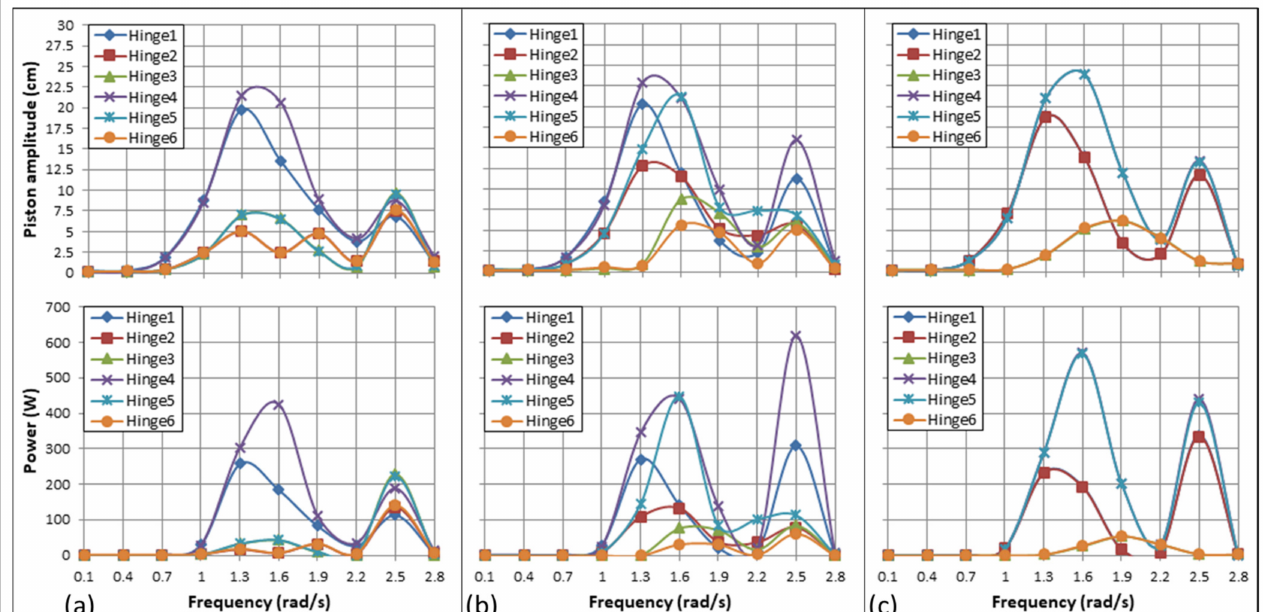
Figure 8. The piston amplitude and power extracted at: ( a ) 0 degrees of incident wave direction; ( b ) 15 degrees of incident wave direction; and ( c ) 30 degrees of incident wave direction.